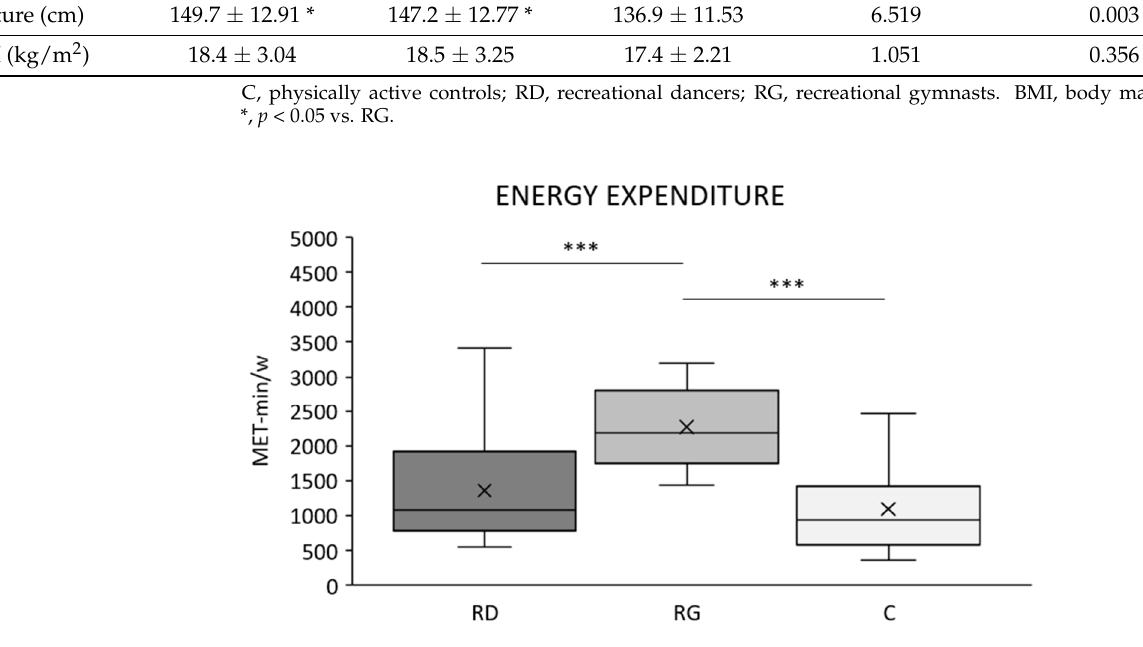
Figure 1. Box plots of estimated weekly energy expenditure (MET-min/w) in the three groups of young girls. RD, recreational dancers; RG, recreational gymnasts; C, physically active controls. ***, p ≤ 0.001. Box, range between the 25th and 75th percentile; solid line, median value; x, mean value; upper whisker, maximum score; lower whisker, minimum score. Table 2. Z-score of the three groups of study participants. One-way ANOVA. Means ± SD.